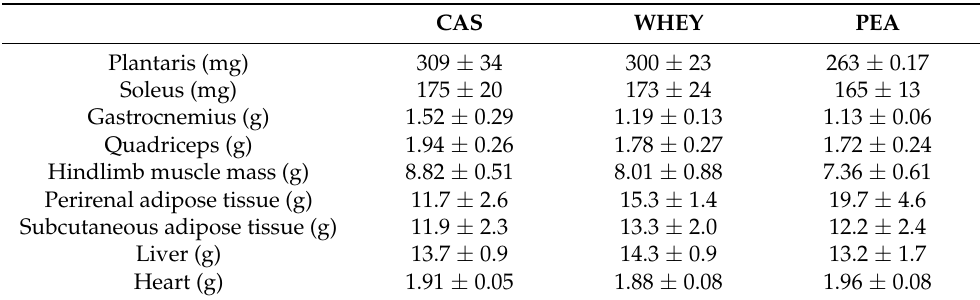
Table 5. Tissue weights in CAS, WHEY and PEA old rats after 16 weeks of different diets. CAS WHEY PEA